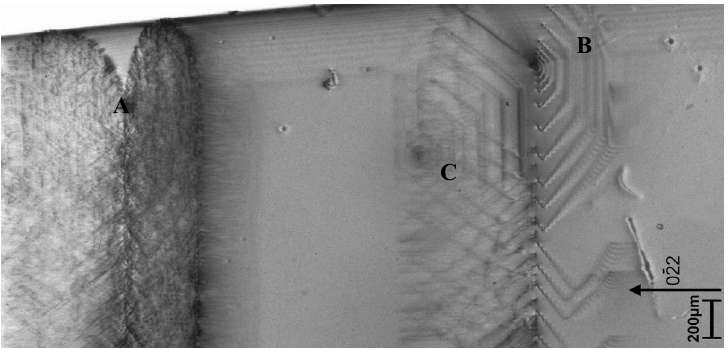
Figure 9. X-ray diffraction image of early stage slip band generation from two adjacent indents close to the bevel edge of the wafer.